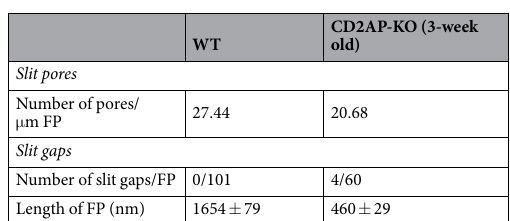
Table 1. Podocyte slit pores, slit gaps and length of foot processes in wild type (WT) and CD2AP deficient mice. FP, foot process. The number of slit pores are analyzed in WT (7.47 μ m of FP length) and 3 week-old Cd2ap -KO (11.94 μ m of FP length) mice. We defined “slit gap” as occurring when three or more consecutive cross-bridging filaments separating slit pores are broken. Length of FP is measured in WT (n = 30) and 3 week- old Cd2ap -KO (n = 24) mice, and presented as means ± standard error of the mean,